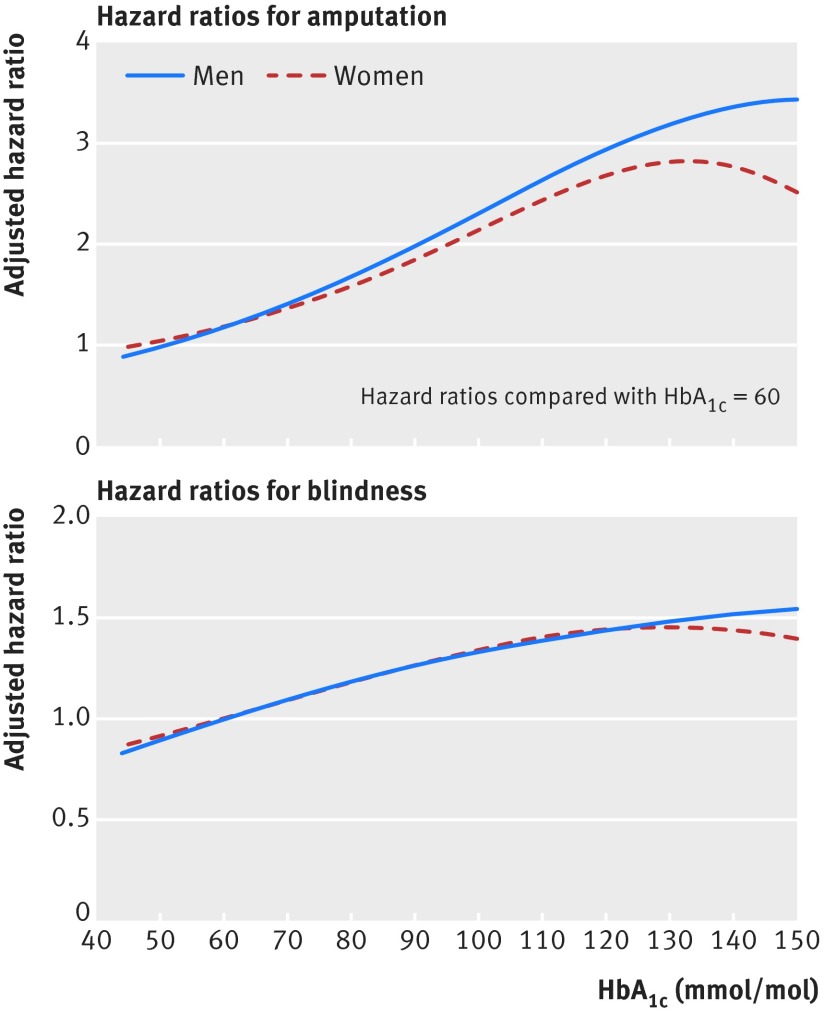
Fig 2 Adjusted hazard ratios for blindness and lower limb amputation by HbA1c in derivation cohort